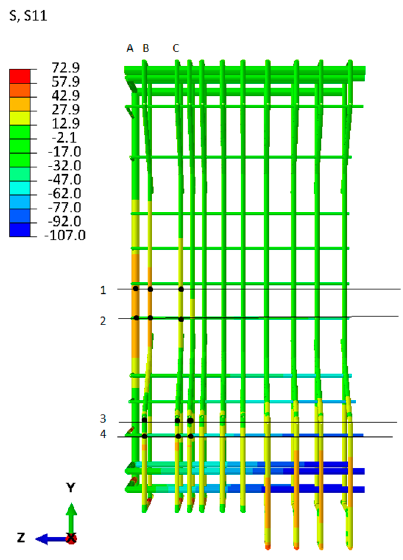
Figure 12. Rebar stresses and indication of the position of the strain gauges (indicative).